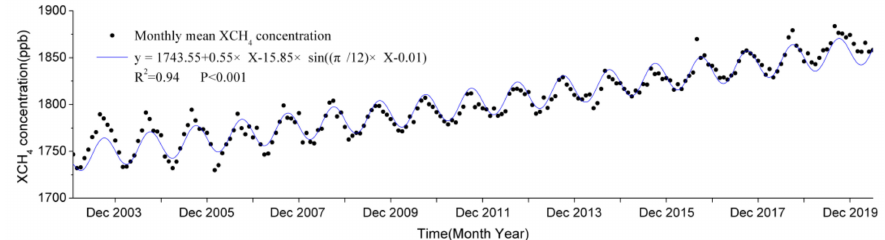
Figure 3. Characteristics of temporal variation in monthly mean XCH 4 concentrations over China